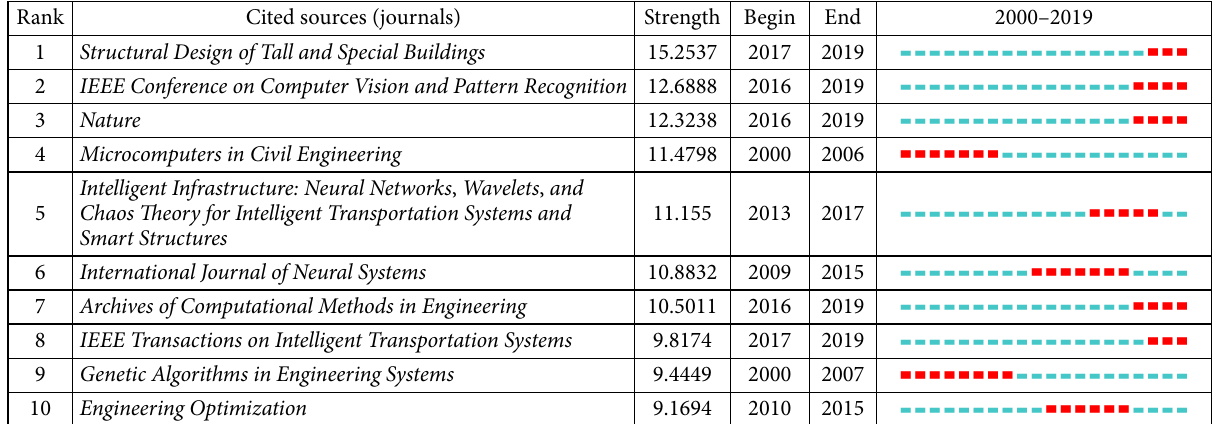
Table 5. The top 10 strongest cited sources (journals) in the CACAIE from 2000 to 2019 Rank Cited sources (journals) Strength Begin Structural Design of Tall and Special Buildings